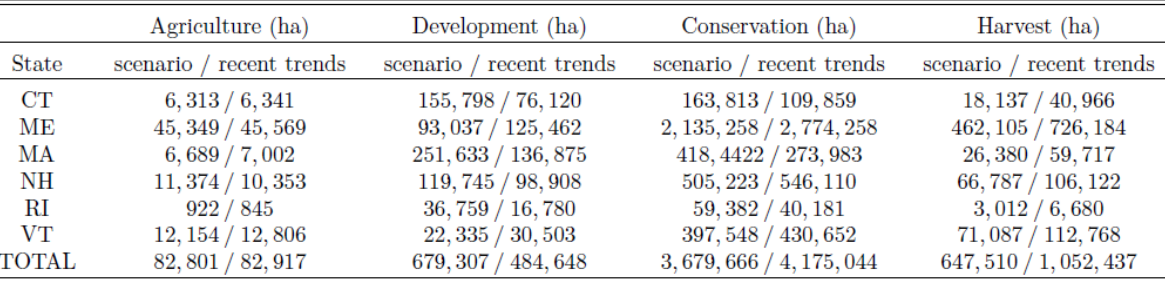
Table A3.2. New Transitions 2010-2060 (Yankee